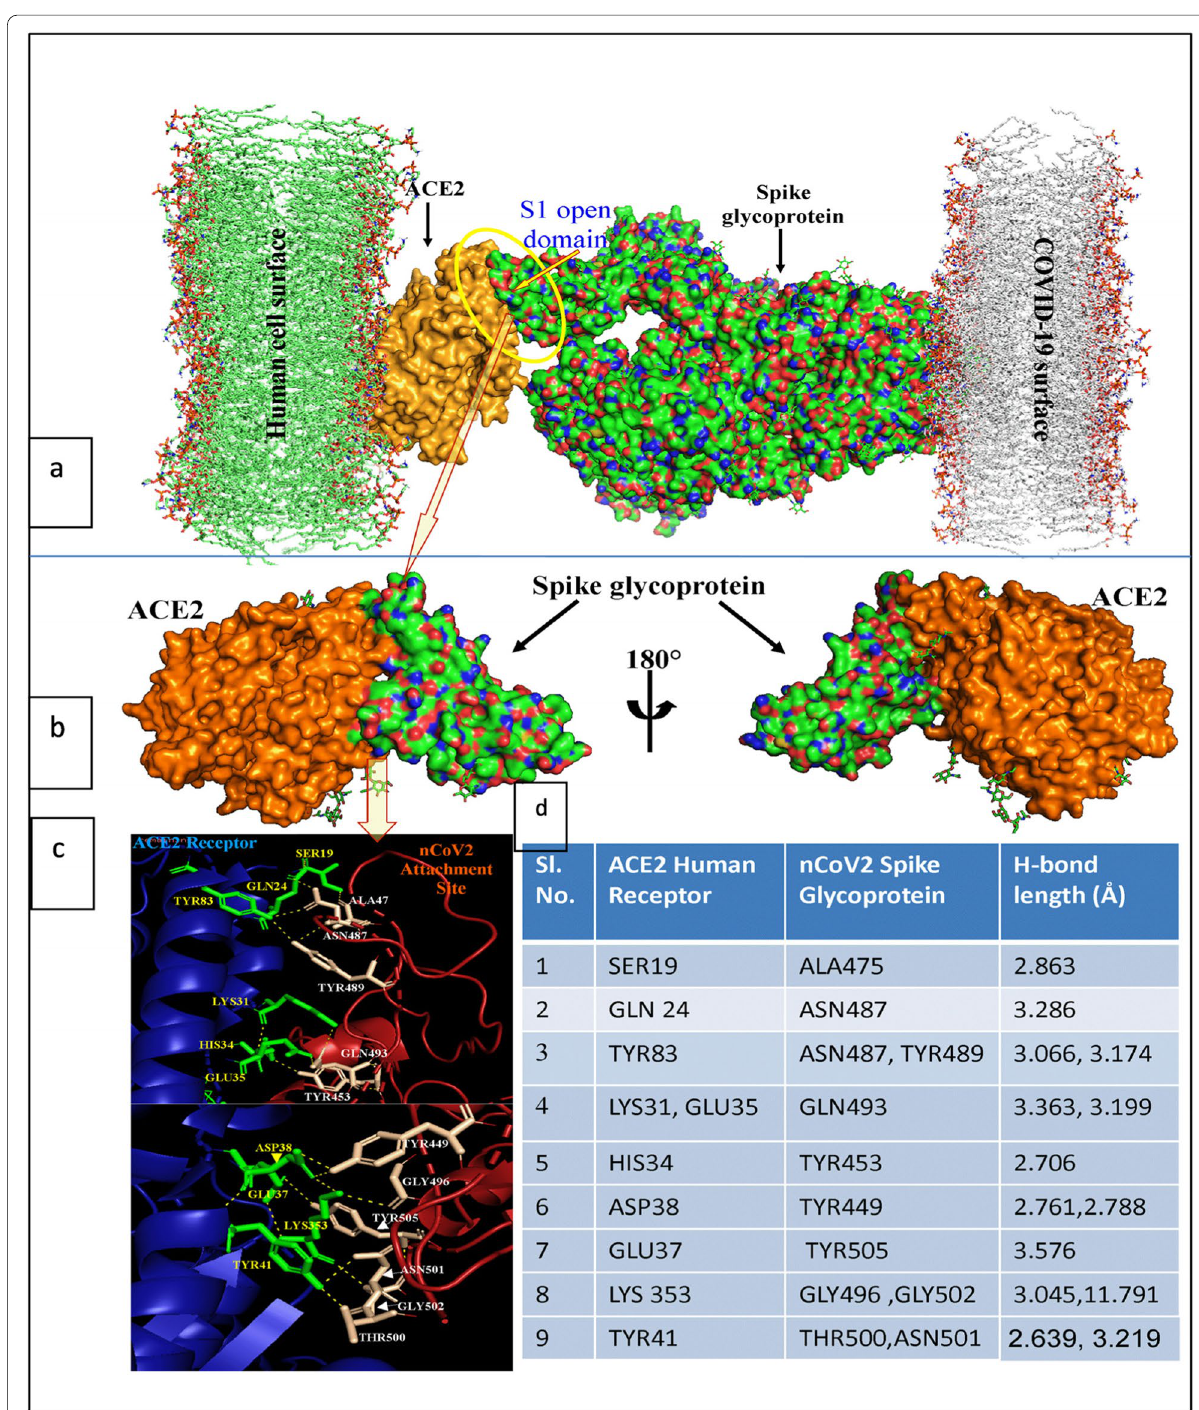
Fig. 1 Attachment of SARS COV-2 spike glycoprotein with human ACE2 receptor. Binding interface represented in Fig a and b . Amino acid interaction pattern represented in figure c . Corresponding hydrogen bond length at each interaction was represented in figure